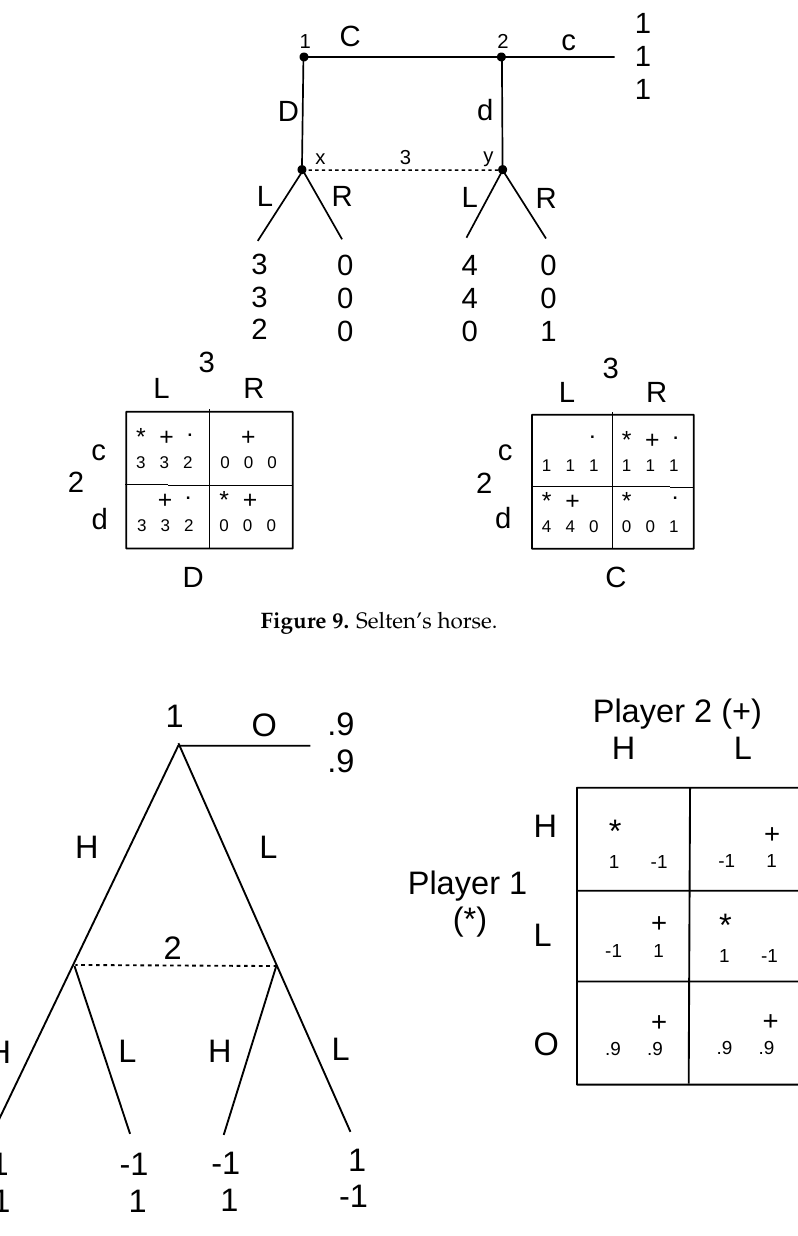
Figure 10. Matching pennies with outside